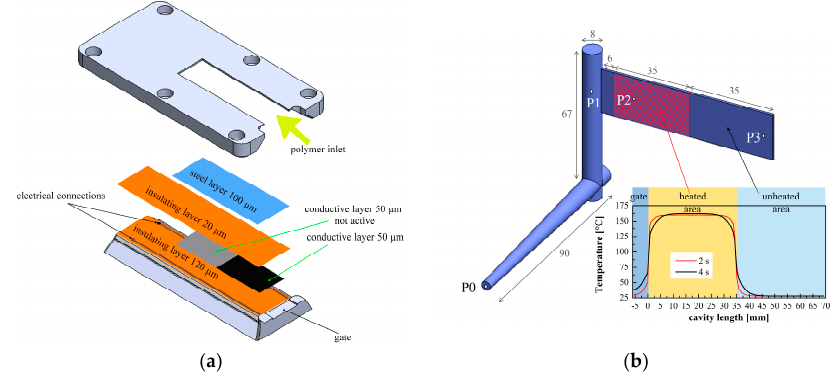
Figure 1. ( a ) Schematic drawing of the mold insert adopted to layer the heater below the cavity surface; ( b ) Sketch of the cavity adopted for the injection molding experiments (measures are in mm), pressure transducer positions (P0–P3) are indicated. A sketch of the surface temperature profile along the flow path is also reported.